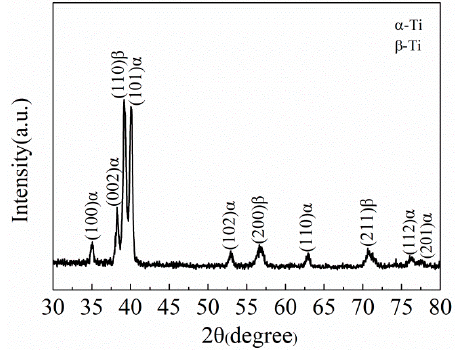
Figure 2. X-ray diffraction spectra of the as-rolled specimen. Figure 2. X-ray di ff raction spectra of the as-rolled